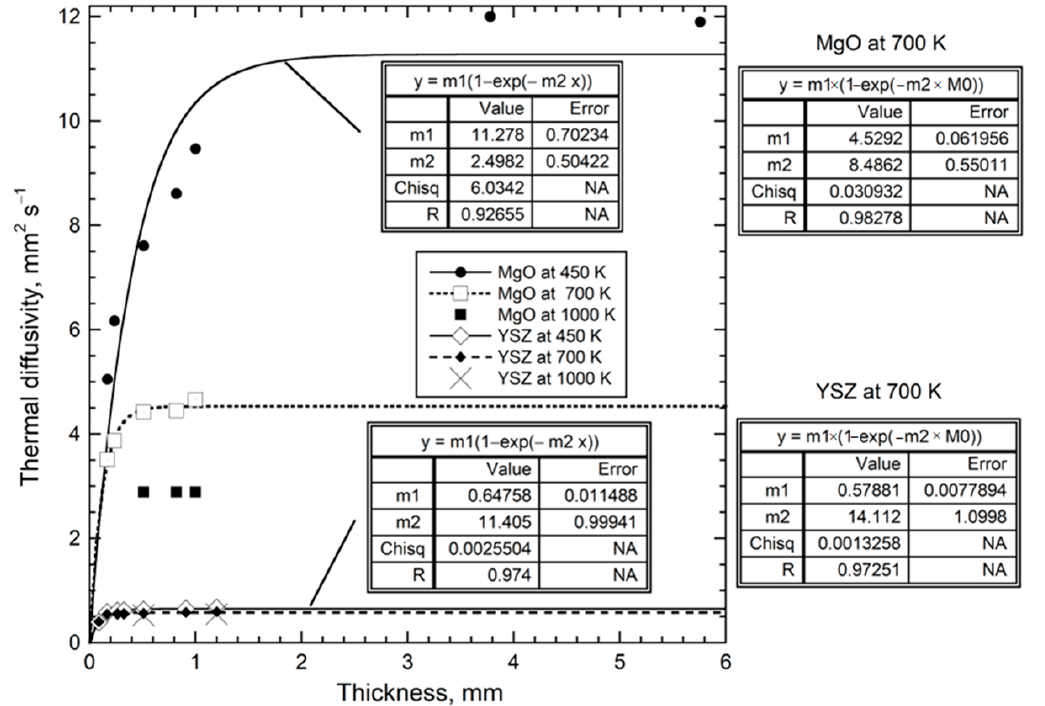
Figure 11. Thermal diffusivity of MgO and YSZ as a function of thicknesses at various temperatures. Insets list fits. Samples are described in Figure 10 and previously in [4,10].